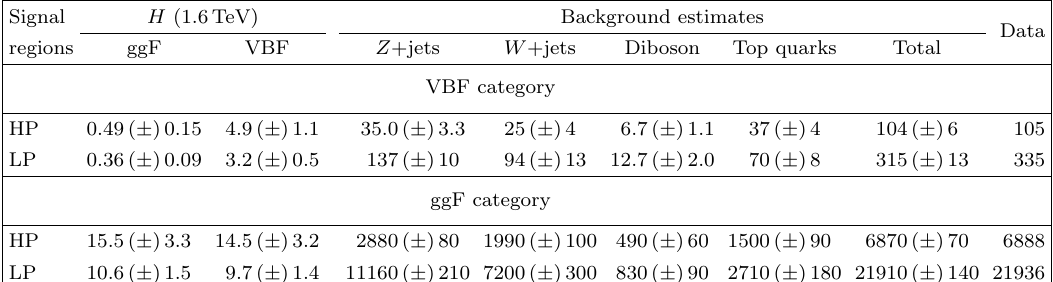
Table 4 . Numbers of events predicted from background processes and observed in the data in the signal regions of the H ZZ (cid:23)(cid:23)qq search from the background-only (cid:12)t of both the signal and ! ! control regions (section 8). The numbers of signal events expected from a Higgs boson with mass of 1.6 TeV are also shown. The signal yields are calculated assuming (cid:27) both ggF and VBF at 1.6 TeV. The uncertainties combine statistical and systematic